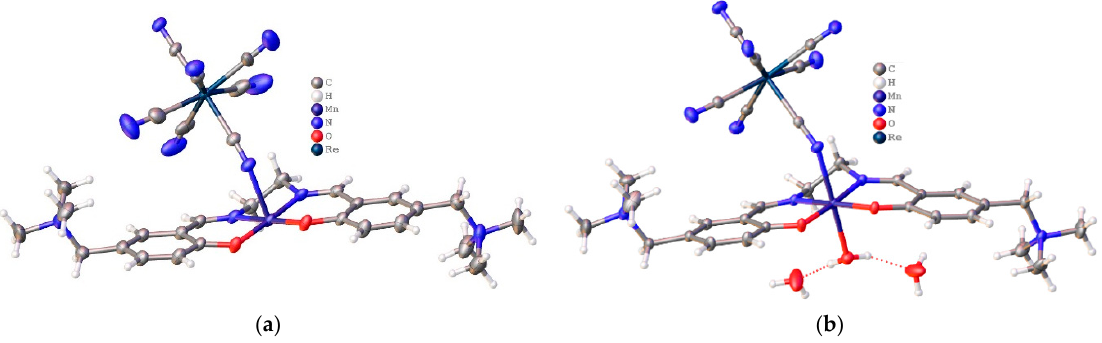
Figure 11. ( a ) The repeating unit in the chain of 12 (solvent water molecules are omitted) and ( b ) the molecular unit in 13 . ORTEP diagrams were generated with 50% probability thermal ellipsoids [46].